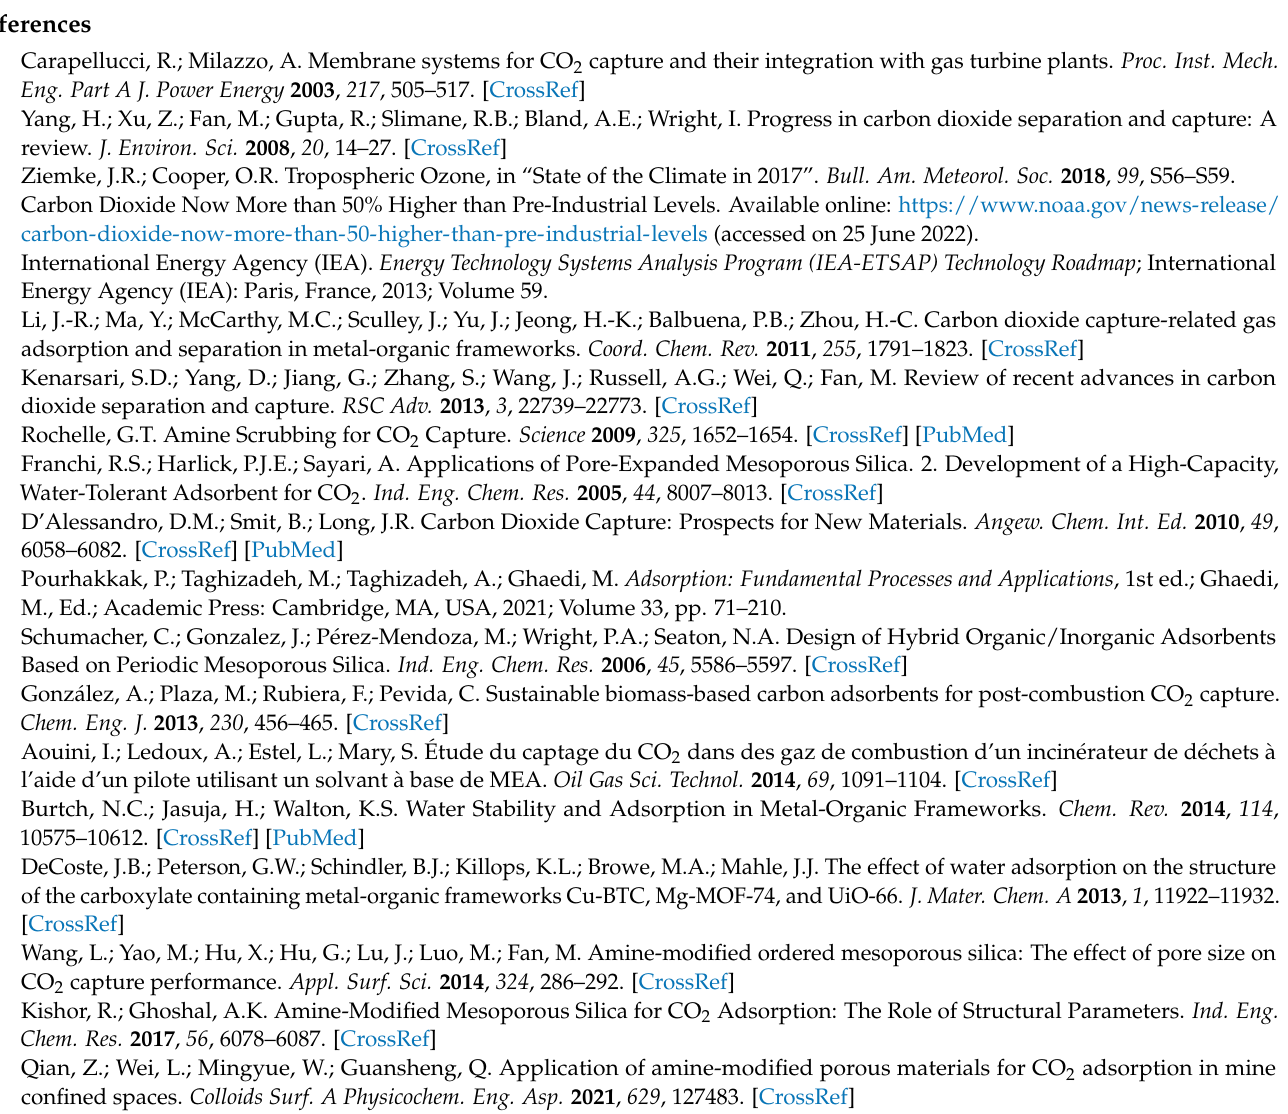
Figure 2; Figure S4: Reactions of amine and carbon dioxide